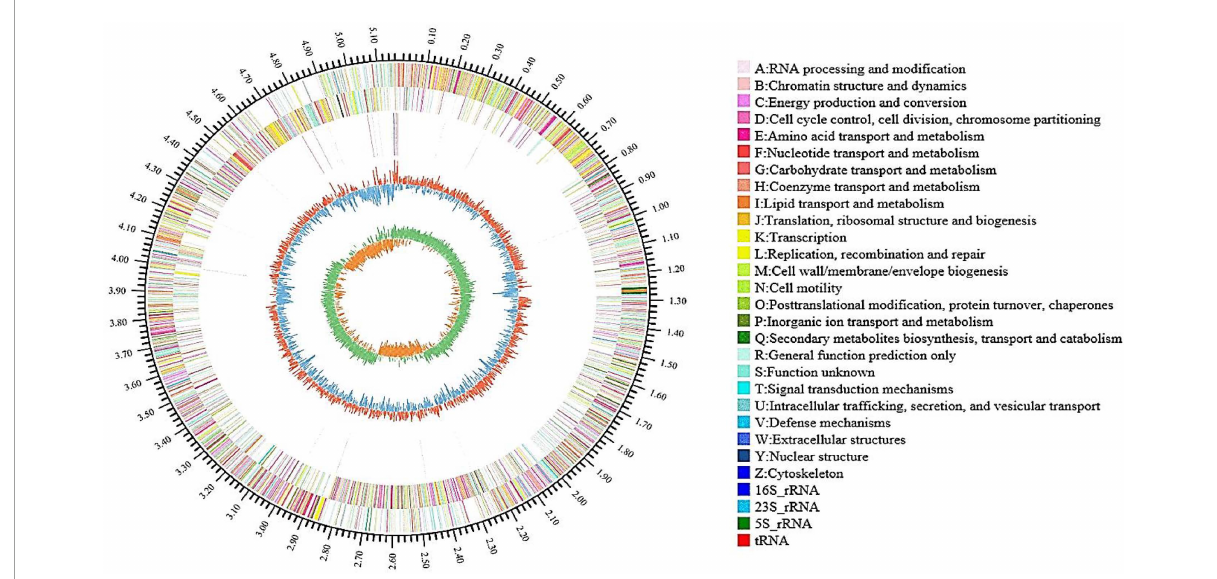
FIGURE4 Genome map of B. aryabhattai TCI-16 (outside to inside): first circle shows the identification of genome information; the second and third circles are CDS distribution on positive and negative strands, and different colors indicate the different functional classification in COG categories; the fourth circle represents rRNA and tRNA; the fifth circle means the GC content, the outward part (red) indicates that the GC content of the region is higher than the average value and the inward part (blue) indicates that is lower, with higher peaks denoting a greater difference from the average GC content; the innermost circle is GC-Skew value.